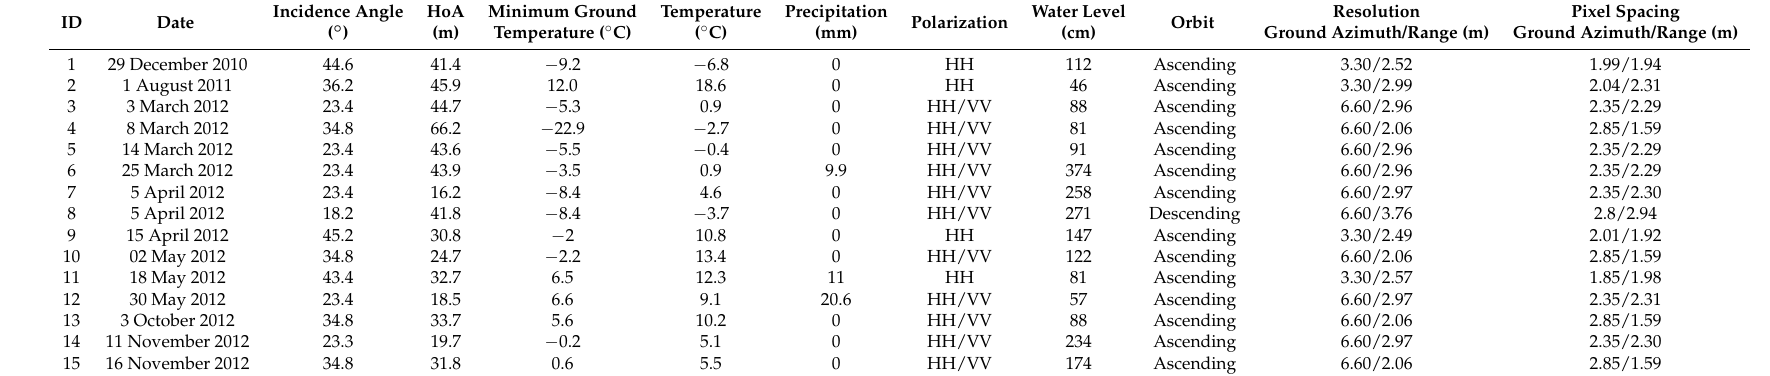
Table 1. The list of bistatic TanDEM-X stripmap acquisitions over the Soomaa test site. HoA is the Height of Ambiguity.